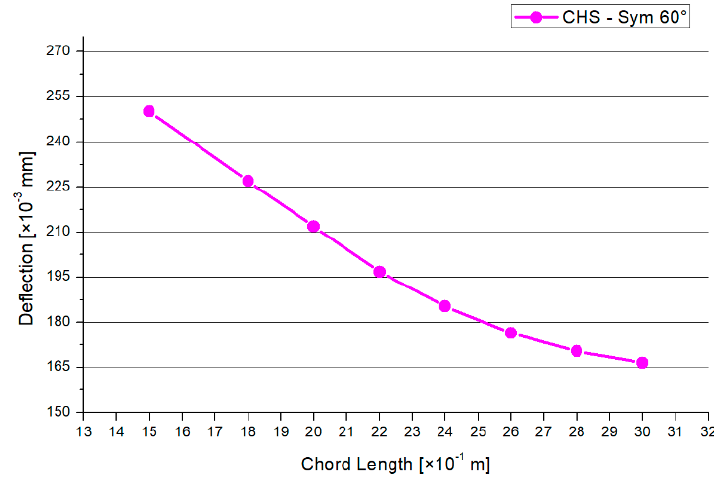
Figure 15. Results—Maximum Deflection.